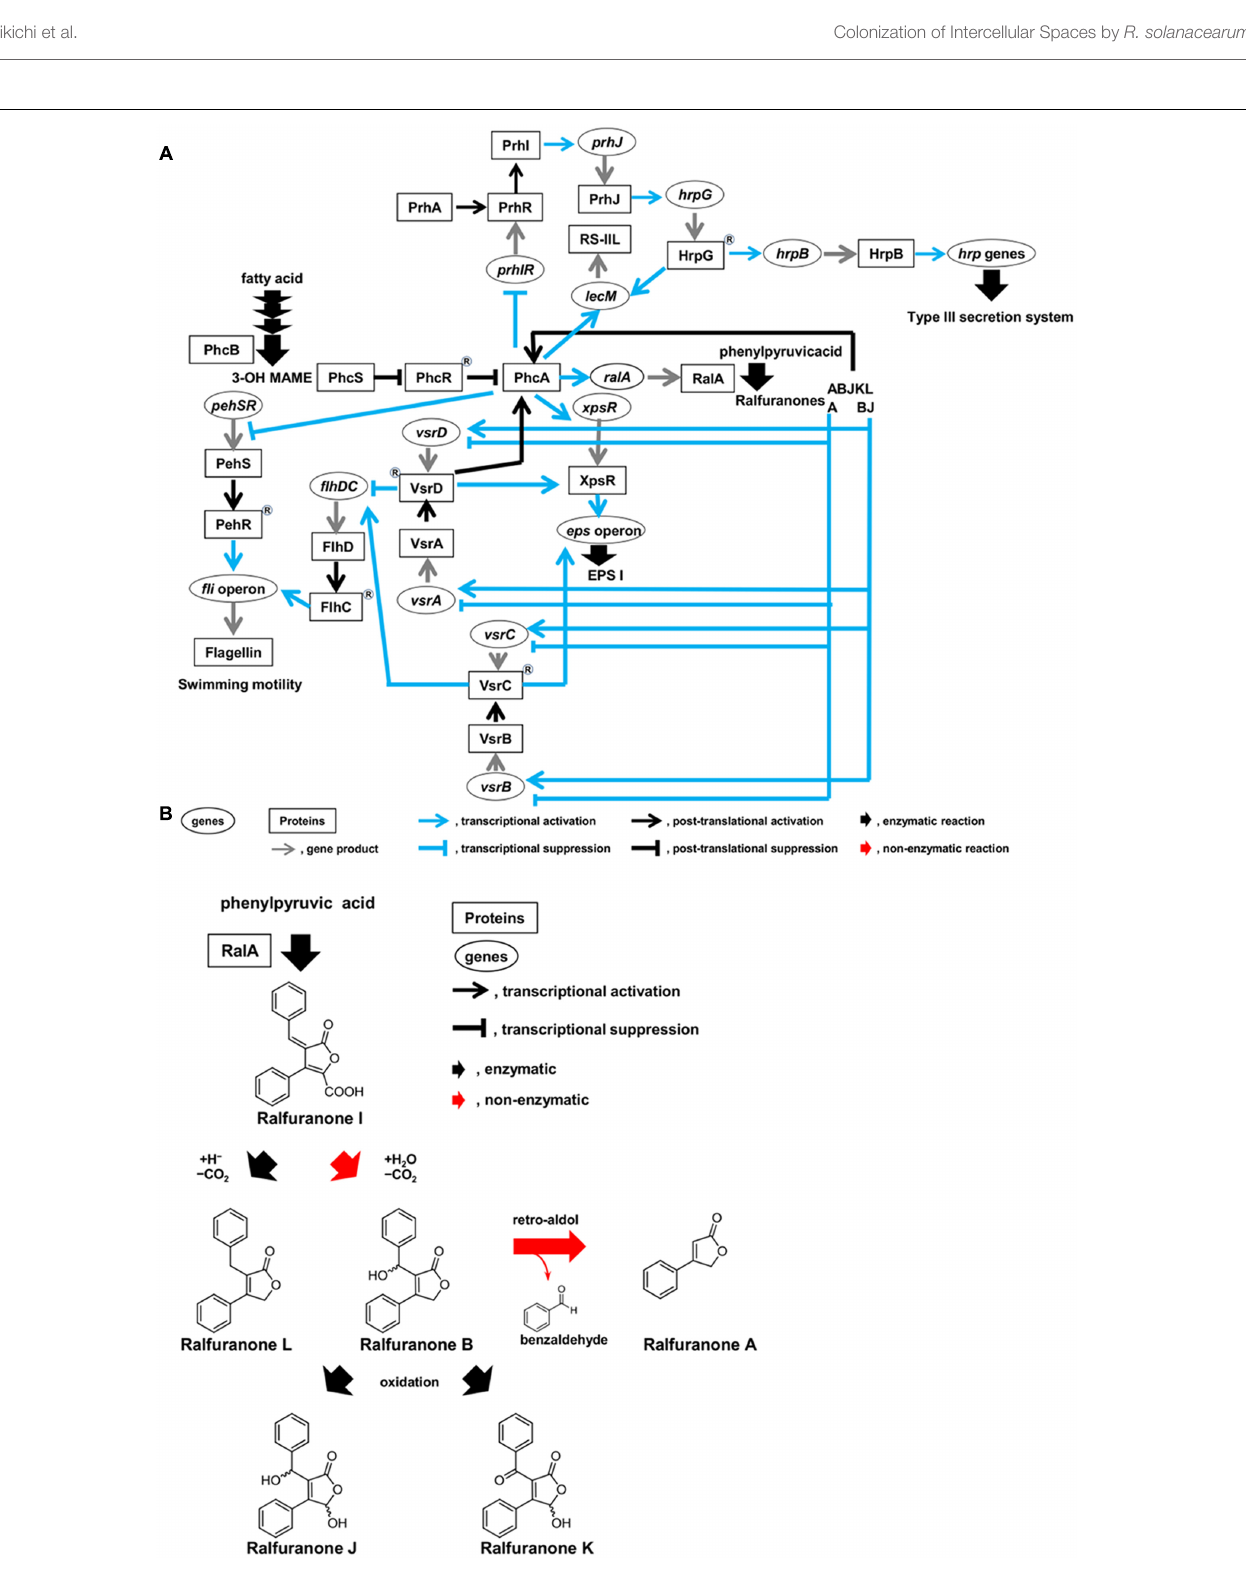
Frontiers in Plant Science |